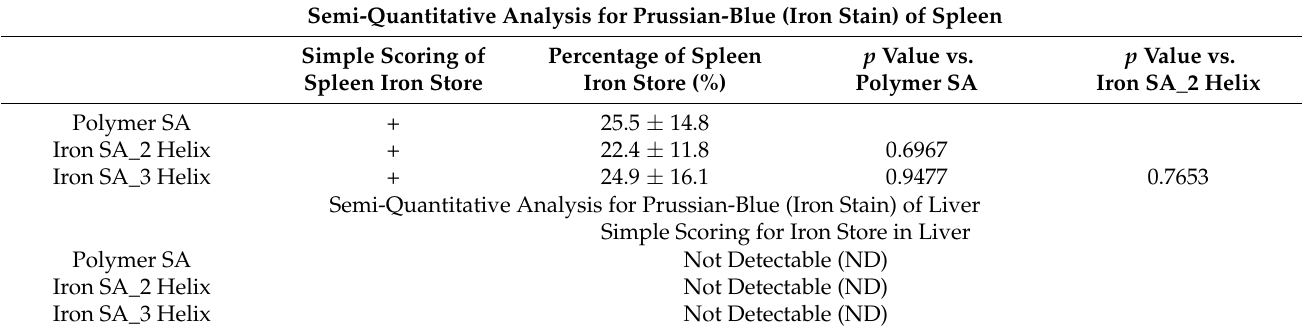
Table 7. Semi-quantitative results for the Prussian blue staining of the liver and spleen. Semi-Quantitative Analysis for Prussian-Blue (Iron Stain) of Spleen Simple Scoring